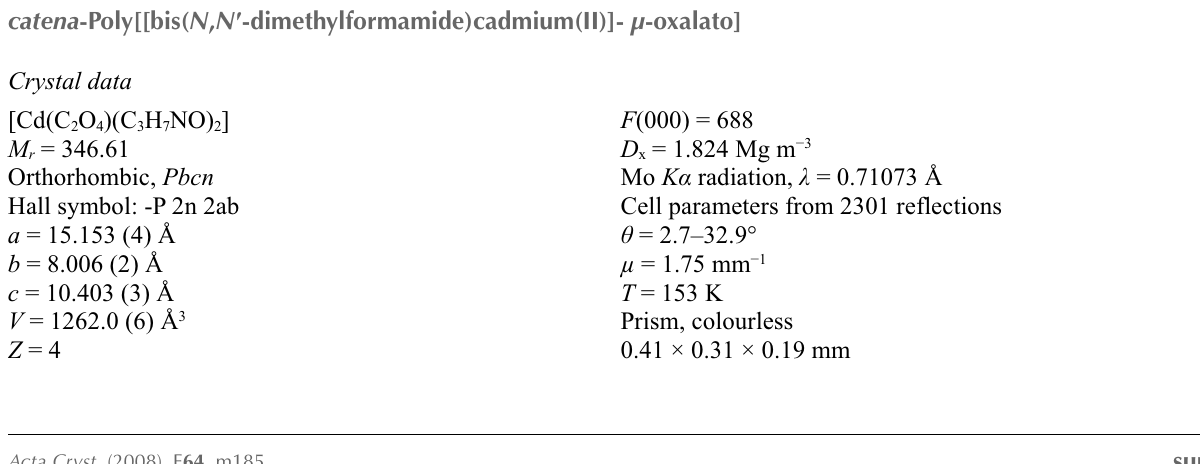
sup-2 Acta Cryst. (2008). E 64 , m185